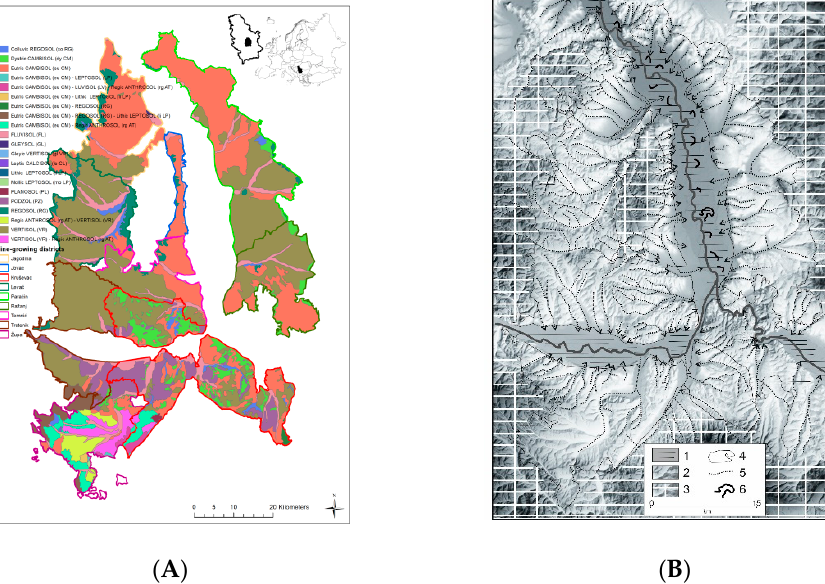
Figure 2. ( A ) Pedological map of the Tri Morave vineyard region and borders of vine growing districts, according the World Reference Base (WRB) soil classification, based on digitalized primary pedological map of the Republic of Serbia 1: 50,000. ( B ) Geomorphological map (1—alluvial plains, 2—dissected fluvial terraces in the zone of low hills, 3—mountain relief zone, 4—borders of the Tri Morava vineyard region, 5—a smaller river valley, 6—paleomeander).